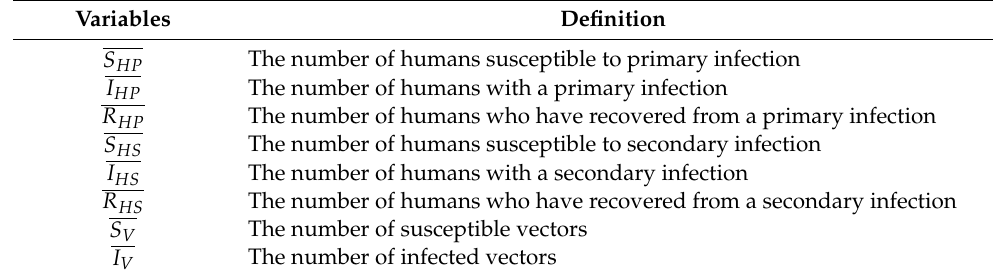
Table 1. The definition of the variables used in the differential system of Equations (1)–(10).